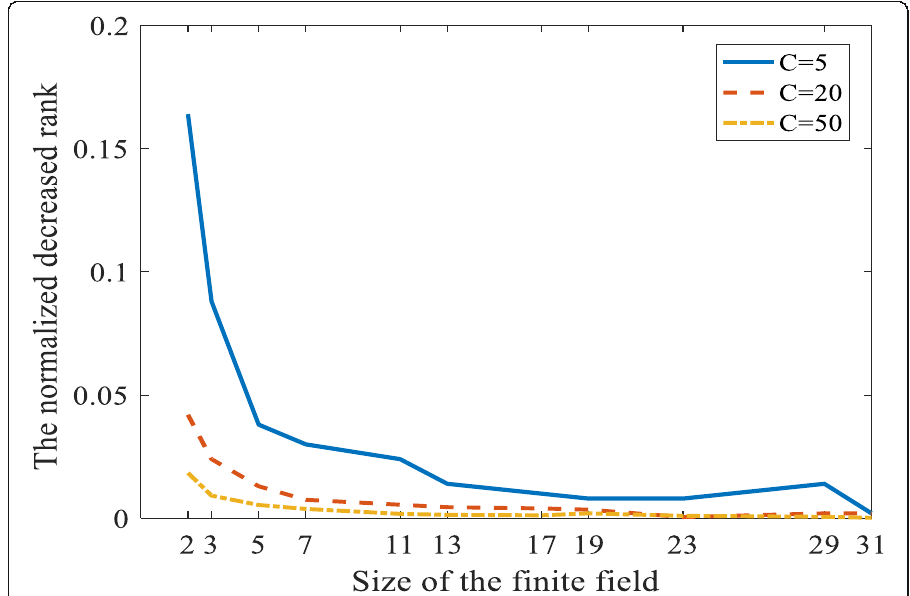
Fig. 3 Normalized decreased rank based on claim 3 when the size of a finite field is odd. Legend: Denote declined amount about rank of T is by ∂ , and the vertical axis characters are ∂ / C . In this case, matrix dimension T is C × C , and its rank is C ‐ ∂